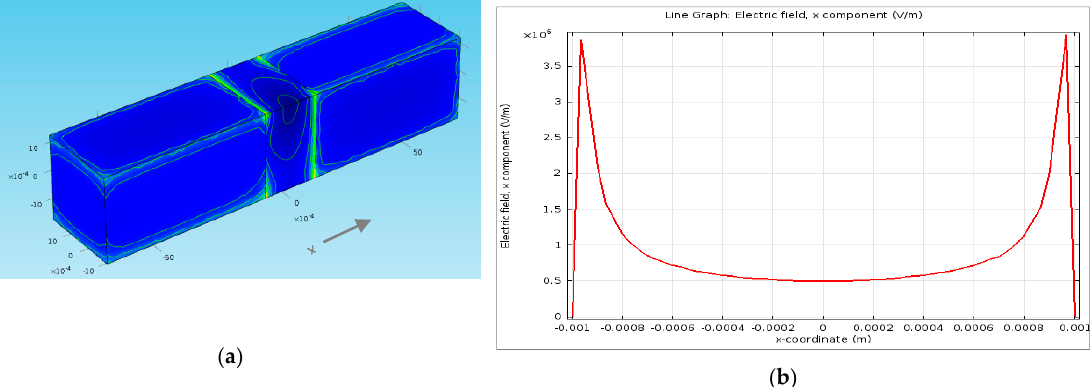
Figure 2. COMSOL simulation of the electric field in the optical transducer generated ( a ) simulation of the electric field in the interfacing region between the two metal electrodes of the crystals at a 2 mm distance; ( b ) profile of the electric field as a function of the distance between the two LiTaO 3 crystals.